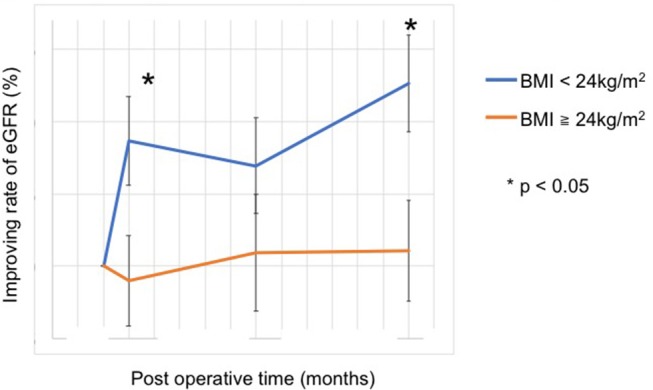
Improvement in the rate of kidney function after adrenalectomy. With a cut-off value at a BMI of 24 kg/m2, the improvement rate of kidney function was worse in patients with BMI ≥ 24 kg/m2 at 1 month and 1 year after surgery (1 month, 8.6 [−6.2–30.4]% vs. −0.9 [−18.9–22.1]%, p = 0.038; 1 year, 12.6 [−14.0–42.4]% vs. 1.1 [−22.2–21.3]%, p = 0.024).